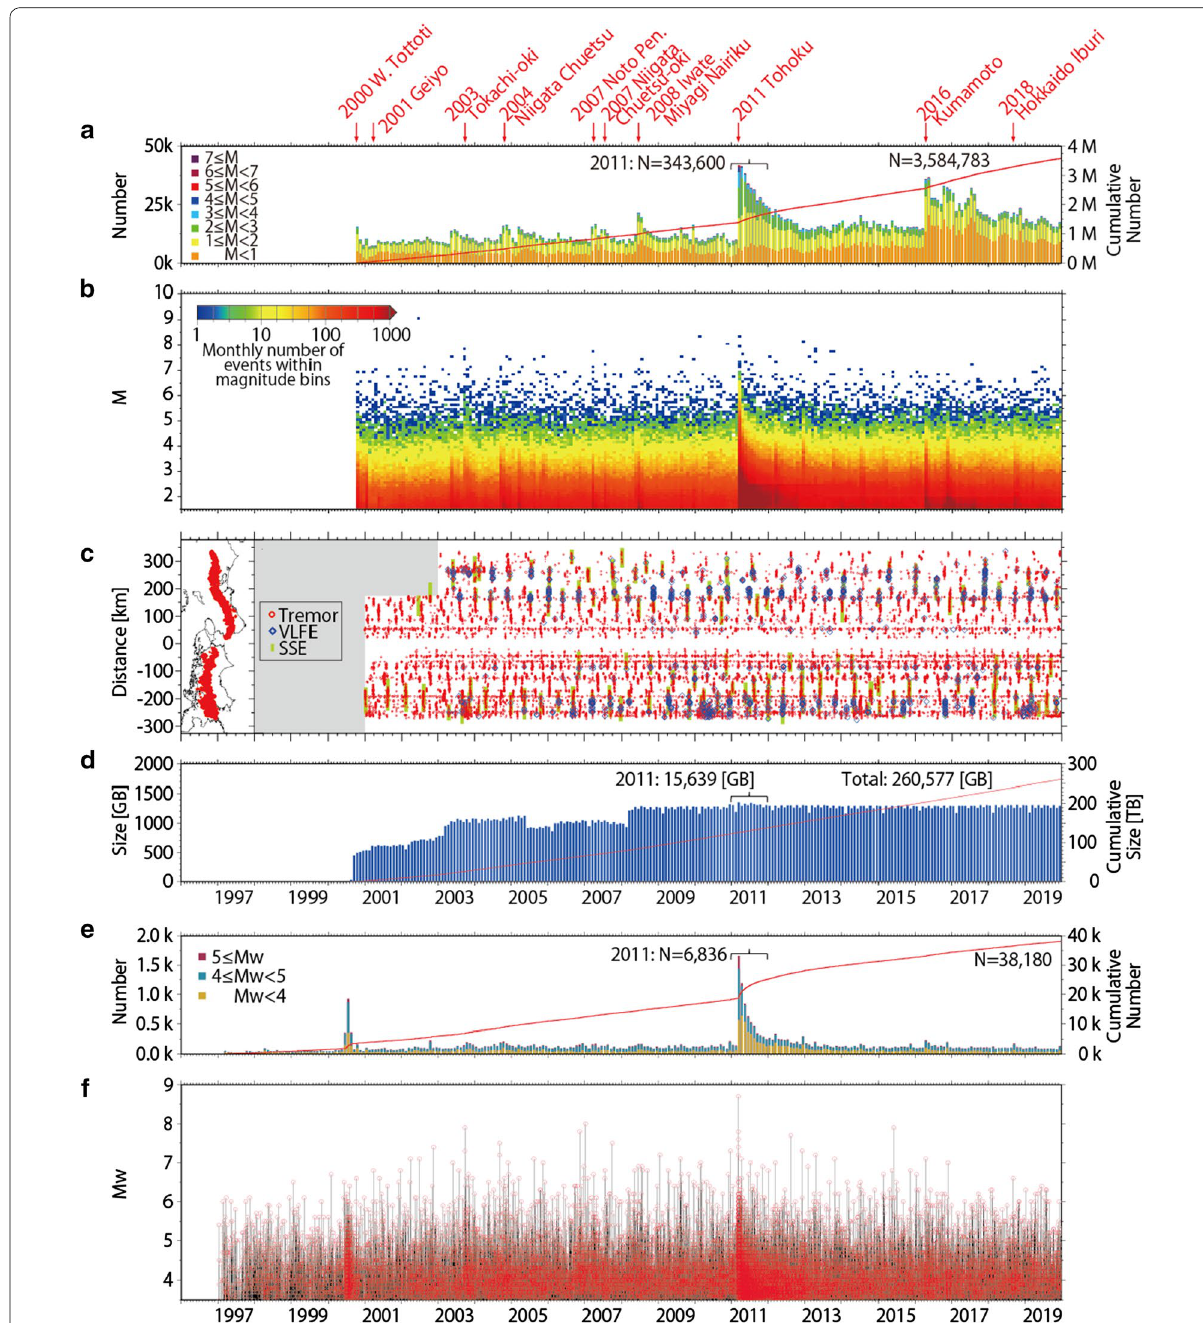
Fig. 9 a Monthly and cumulative numbers of Hi-net events up to the end of 2019. The histogram indicates the number of Hi-net events in each month. The red line indicates the cumulative number of events since October 2000. b Magnitude distribution of monthly Hi-net events. The color scale denotes the monthly Hi-net events within each bin with a magnitude width of 0.1. c Spatial (left) and spatiotemporal (right) distribution of tremors. The red circles denote tremors. In the right panel, VLFEs and SSEs are shown by the blue diamonds and green lines, respectively. d Monthly and cumulative sizes of Hi-net waveform data. The histogram indicates data size of Hi-net events for each month. The red line shows cumulative data size since October 2000. e Monthly and cumulative numbers of F-net moment tensor solutions. The histogram indicates the number of F-net moment tensor solutions. The colors indicate the magnitude range. The red line shows the cumulative number of F-net moment tensor solutions since January 1997. f Temporal distribution of moment magnitudes of F-net moment tensor solutions. The red circles denote moment